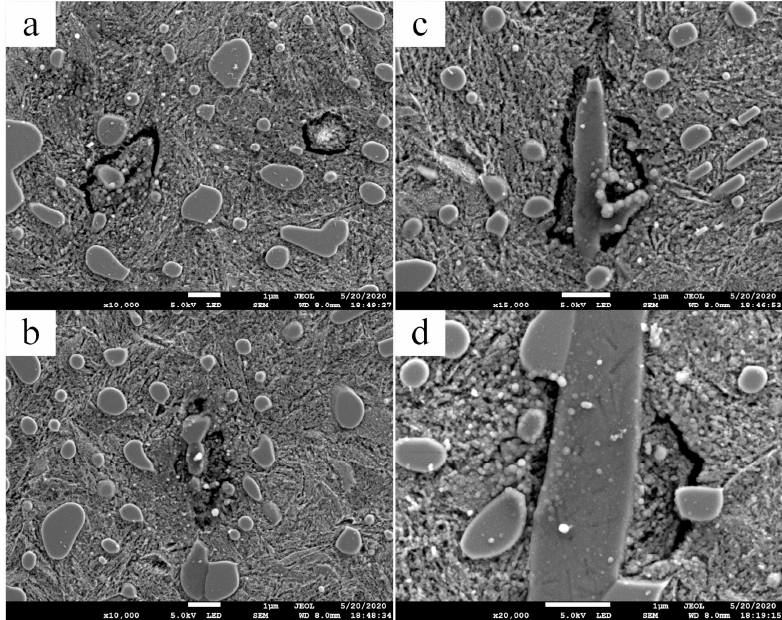
Figure 16. Transfer of materials observed inside the plate specimen in 0.0 mm section. ( a ) 03# inclusion; ( b ) 04# inclusion; ( c ) 05# inclusion; ( d ) 07# inclusion. Inclusions positions are shown in Figure 17.